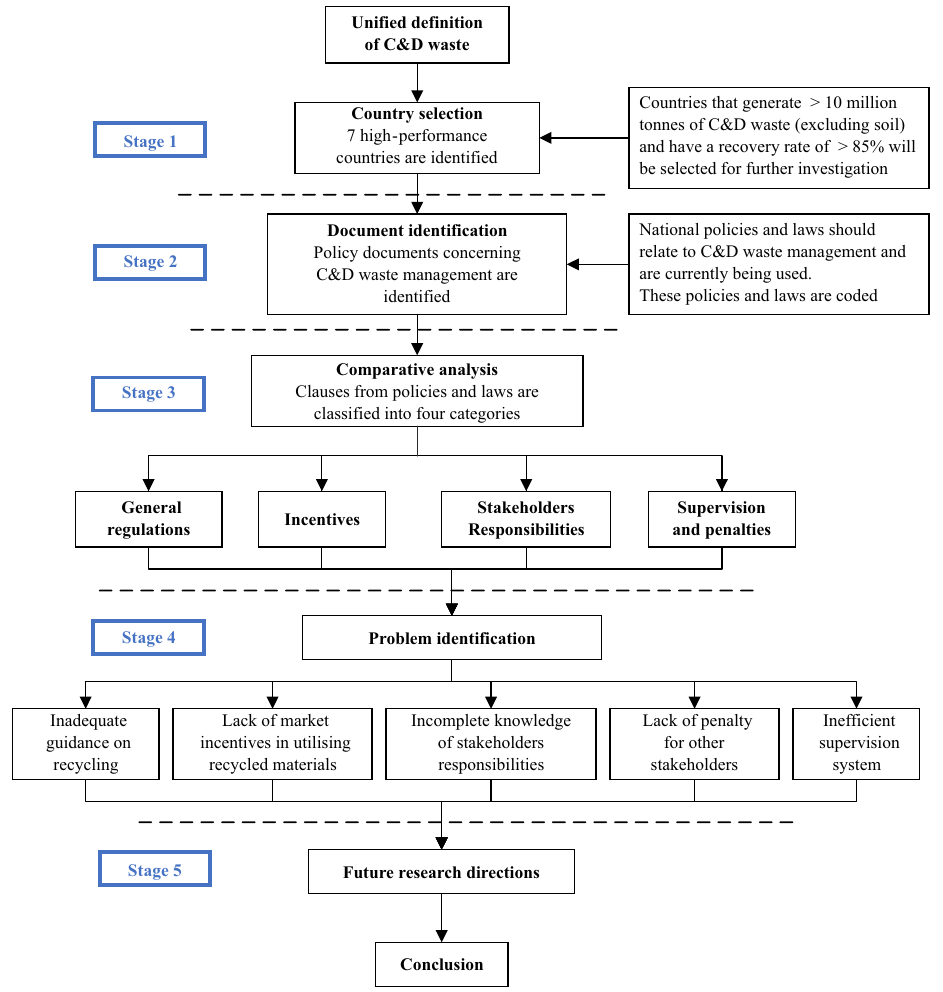
Figure 1. The research framework of this